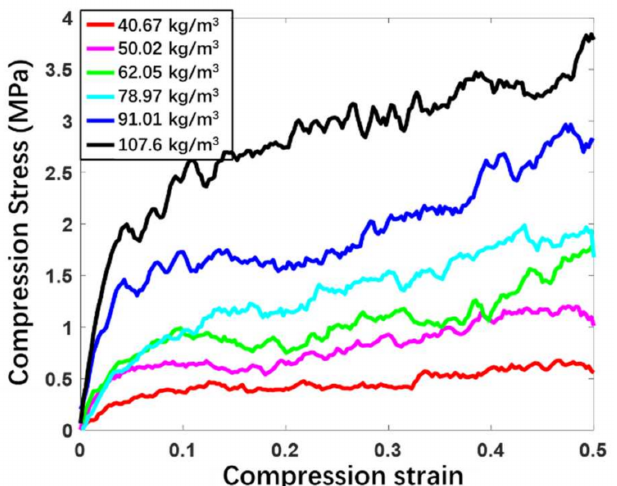
Figure 2. Compression stress as a function of compression strain for buckypapers with different densities.